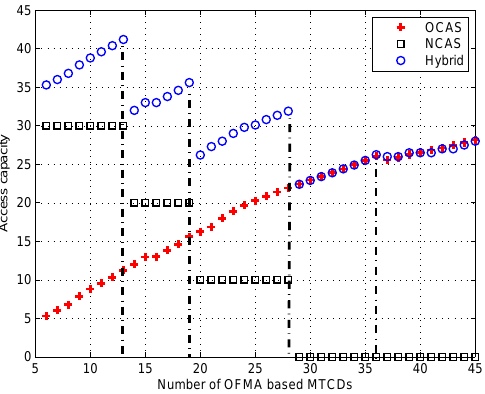
Figure 6. Comparison of the access capacity among the hybrid NOMA-OFDMA, NCAS, and